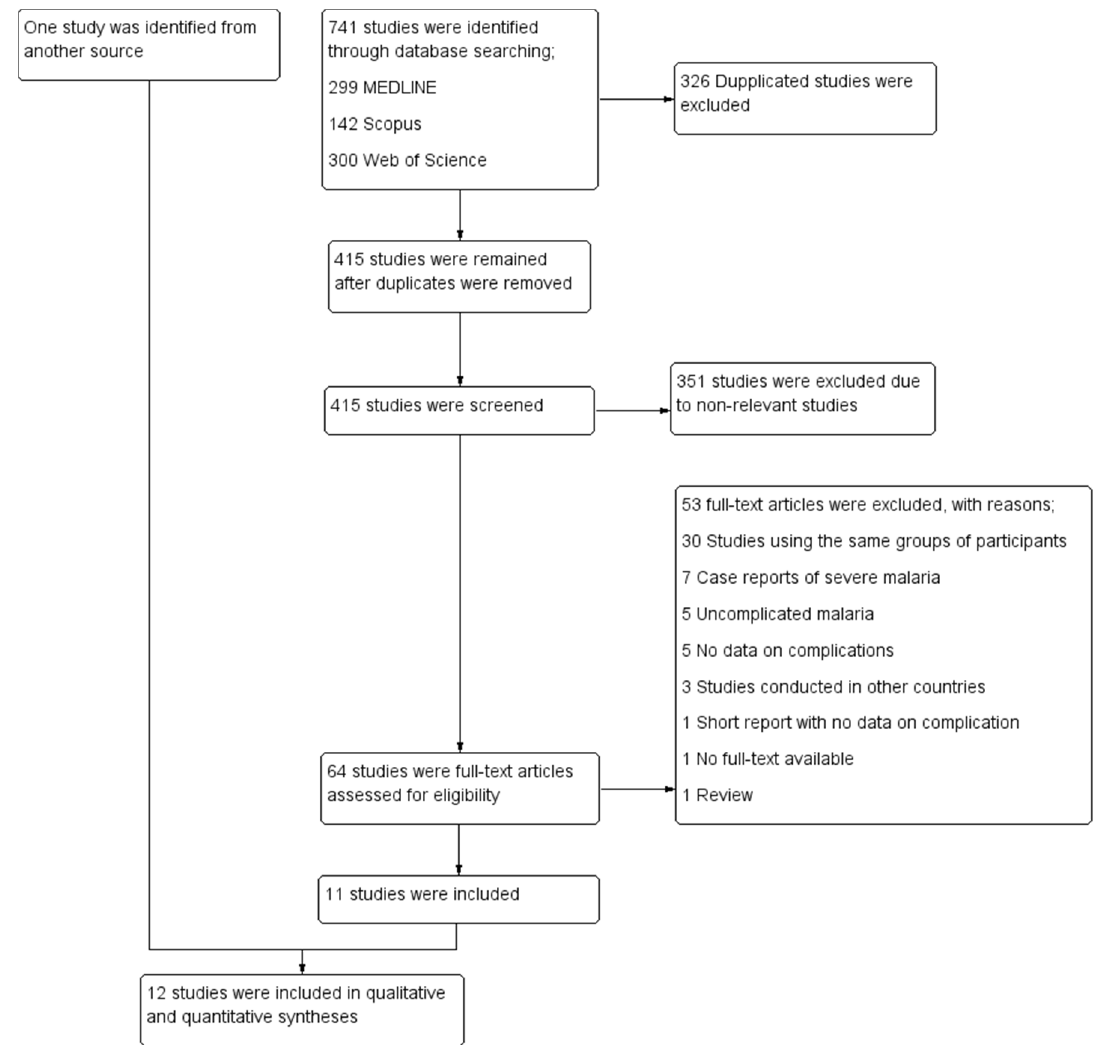
Figure 1. Study selection .